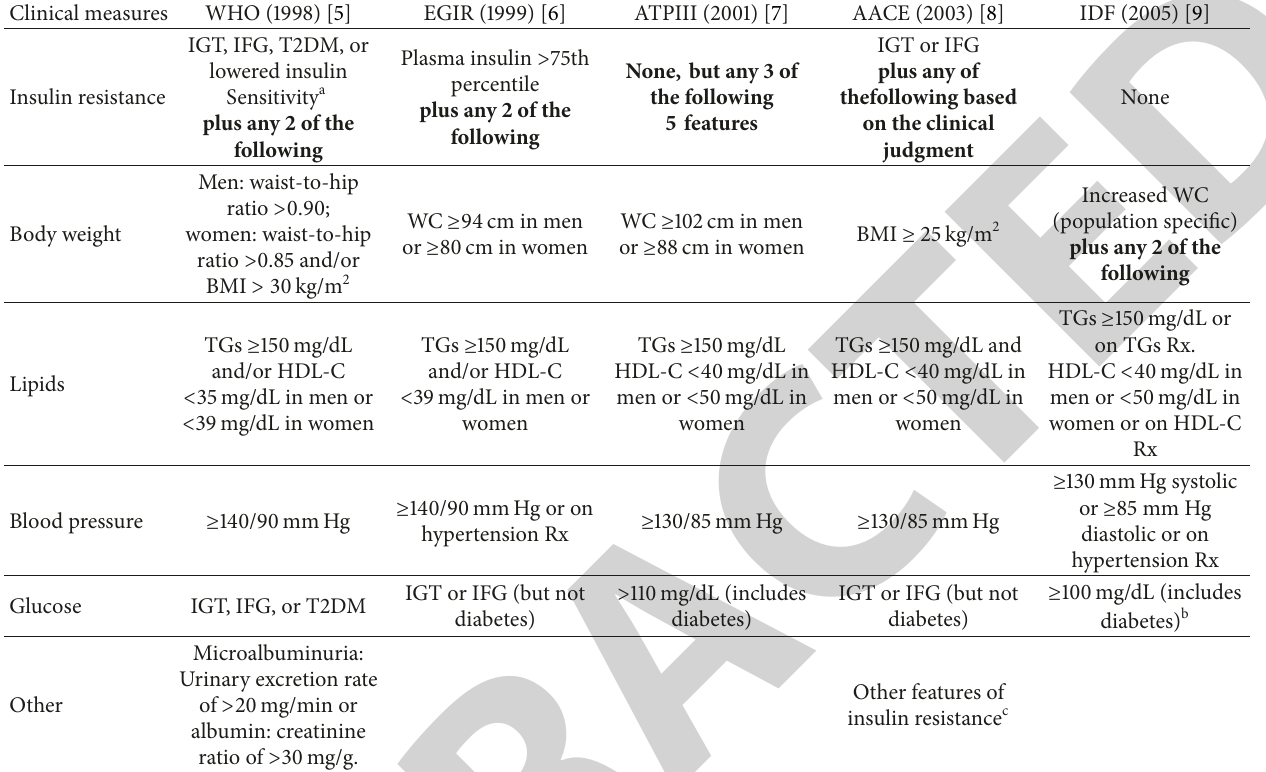
Table 1: Diagnostic criteria proposed for the clinical diagnosis of the